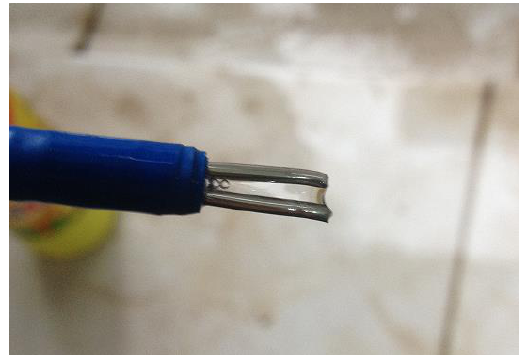
Figure 7. Water film phenomenon.